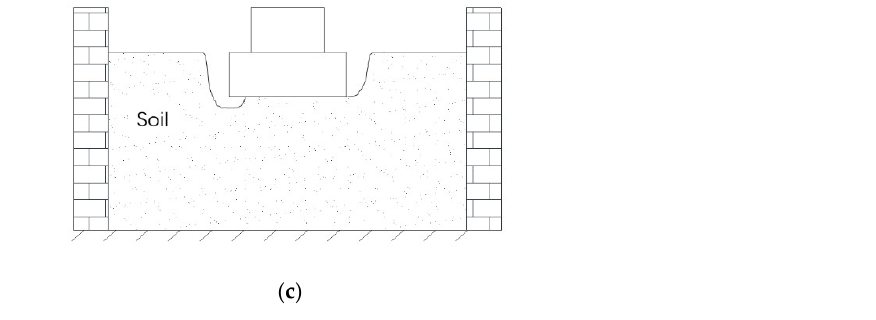
Figure 13. Dynamic stiffness changes with soil constraint states for model S1.